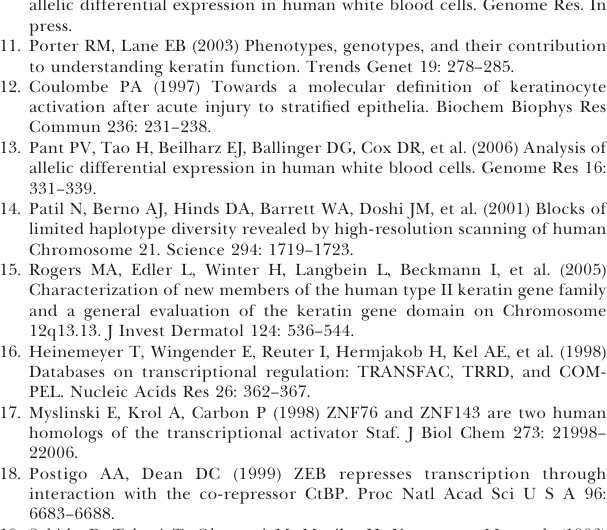
Table S1. The 29 SNPs in the KRT1 Haplotype Block Table S2. KRT1 Interval Haplotype Patterns in the 23 Haploid Coriell DNA Polymorphism Discovery Resource Samples The KRT1 haplotype patterns presented in this table were deter- mined as described by Patil et al. [14]. Briefly, we generated 50 ethnically diverse haploid genomes from the Coriell DNA Poly- morphism Discovery Resource, using somatic cell radiation. Long- range PCR products approximately 10 kb in length were digested, labeled, and hybridized to a series of SNP discovery arrays. We used a dynamic programming algorithm to partition the SNPs into haplotype blocks. SNPs with minor allele frequencies of at least 10% in the Coriell individuals were included in the map. We required all blocks to satisfy the condition that at least 80% of the haploid samples could be assigned to common haplotype patterns having (cid:1) 10% frequency. In the genomic region surrounding KRT1, 23 ethnically diverse haploid genomes were used for SNP discovery and haplotype map construction. Table S3. Forward (F) and Reverse (R) Oligonucleotides Used in the Electrophoretic Mobility Shift Assay Table S4. Forward (F) and Reverse (R) PCR Primers Used to Generate Luciferase Reporter Constructs. Found at DOI: 10.1371/journal.pgen.0020093.st004 (68 KB